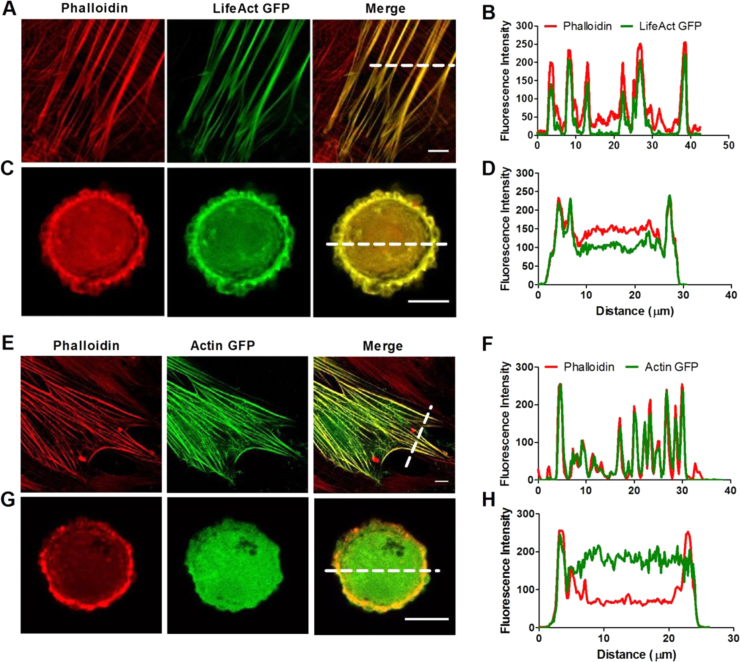
Co-localisation of F-actin labelled with LifeAct-GFP or actin-GFP and Alexa Fluor 555-phalloidin. hMSCs were transfected with LifeAct-GFP or actin-GFP, fixed and counter stained with Alexa Fluor 555-phalloidin. Confocal images of representative cells expressing LifeAct-GFP (A and C) or actin-GFP (E and G) and imaged in monolayer (A and E) or suspension (C and G) culture. White dotted lines indicate the position of fluorescent intensity profiles across the actin stress fibres in monolayer (B and F) or cortical actin in suspension (D and H). Scale bars represent 10 µm.